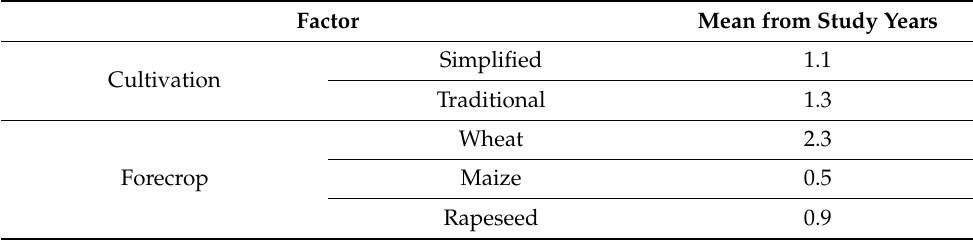
Table 3. Percentage of flag leaf area infected by Pyrenophora tritici-repentis. Reprinted from reference